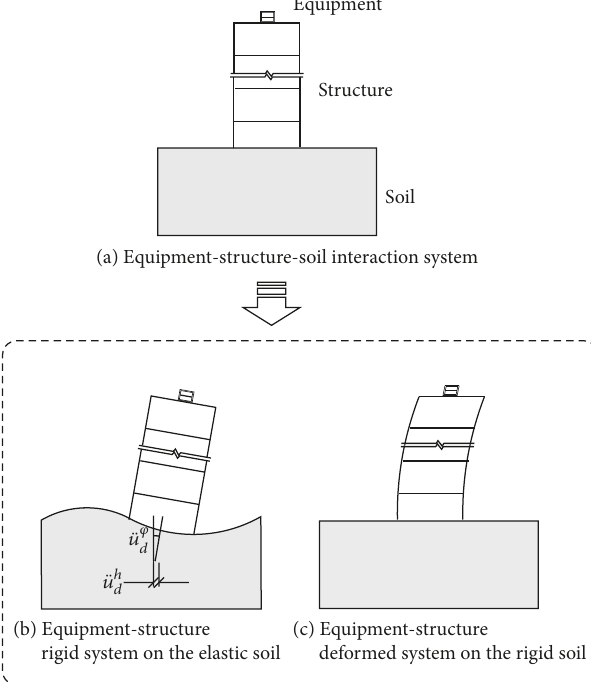
Figure 1: Schematic for motion equation of the ESS interaction